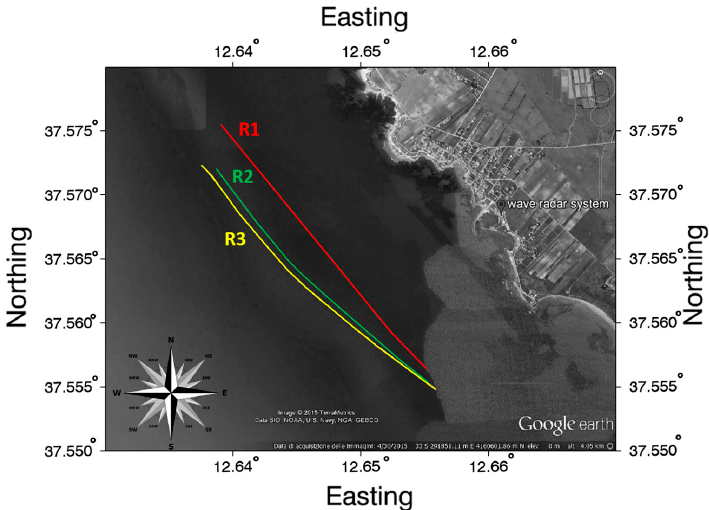
Figure 3. Red, green and yellow lines are the trajectories of the releases R1, R2, R3, respectively. The drifters moved towards the North-West.